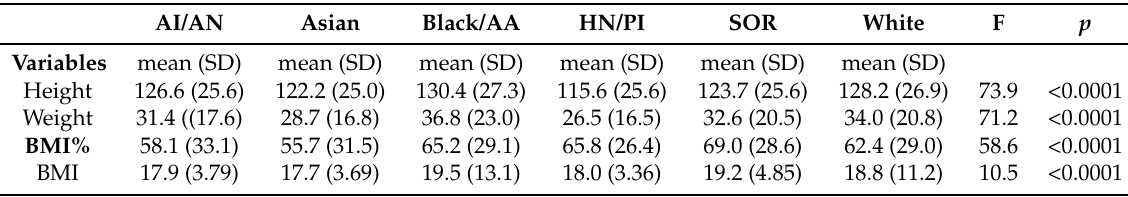
Table 3. Study characteristics by race (continuous